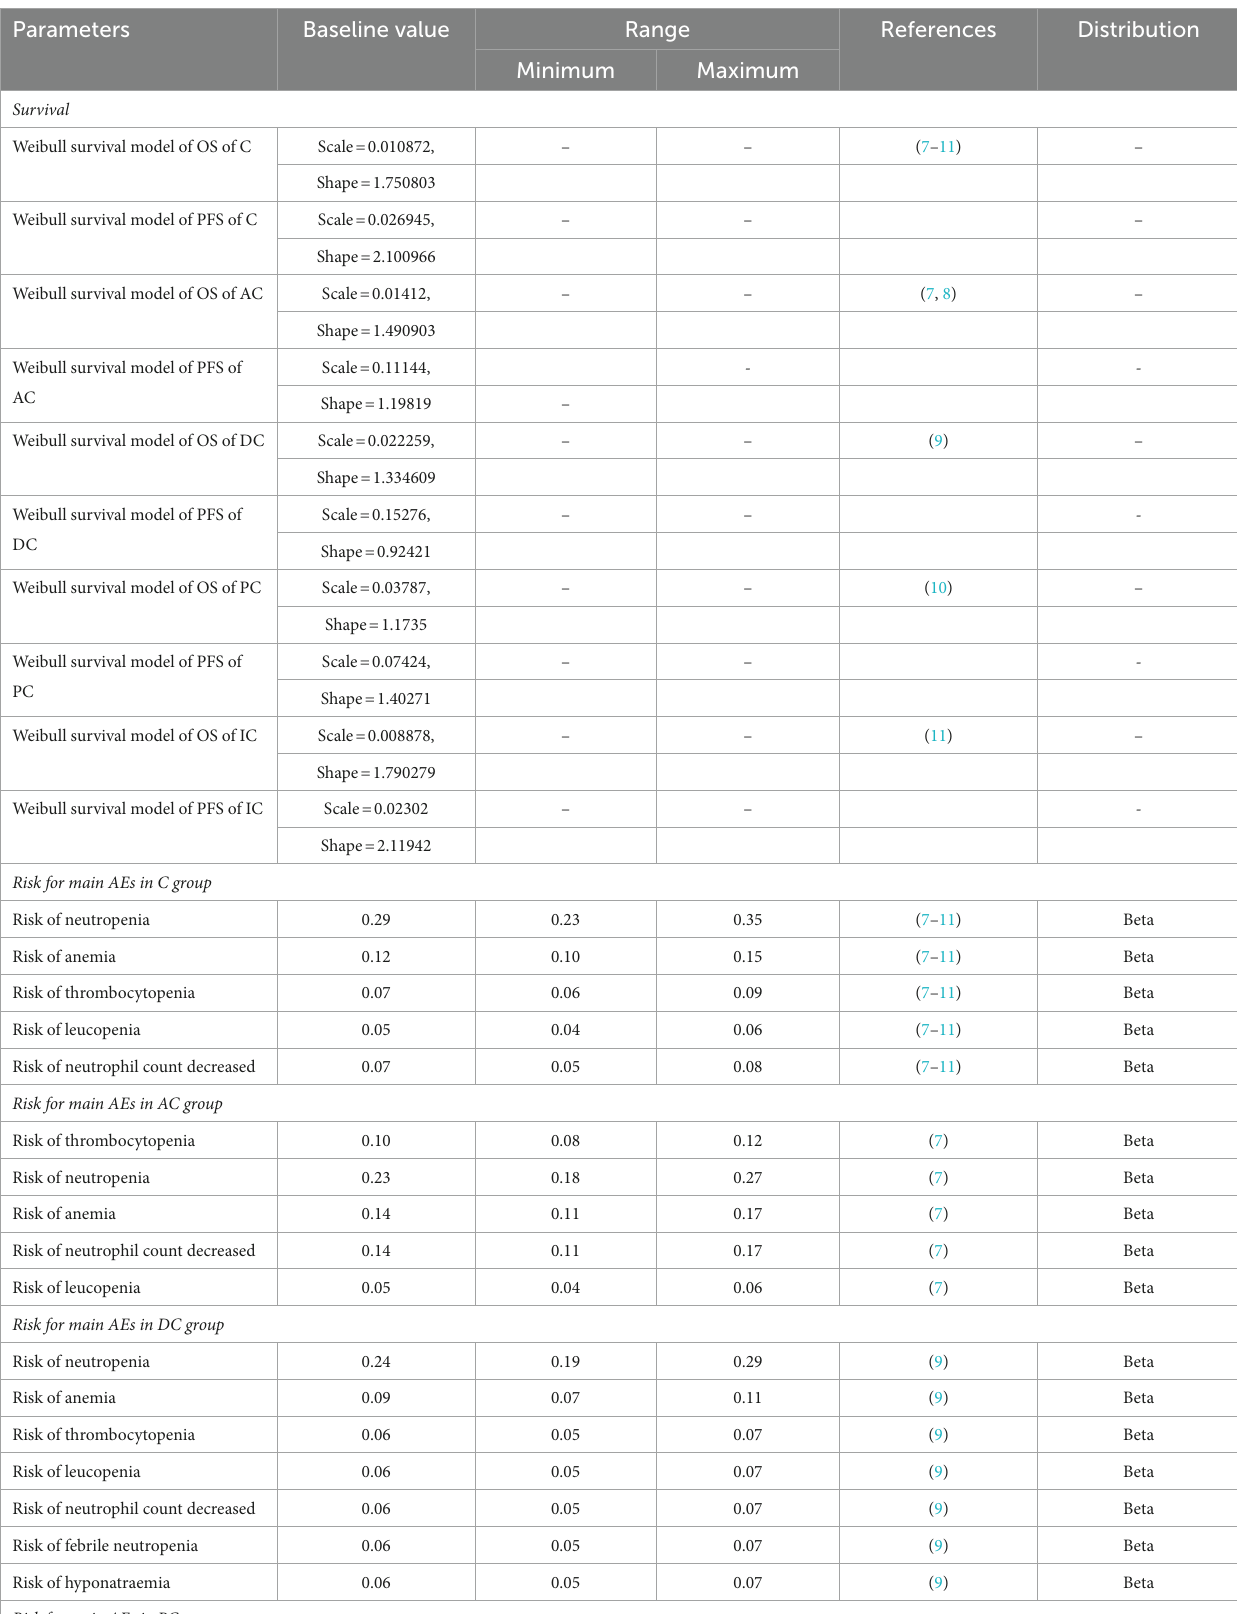
TABLE 1 Model parameters: baseline values, ranges, and distributions for sensitivity